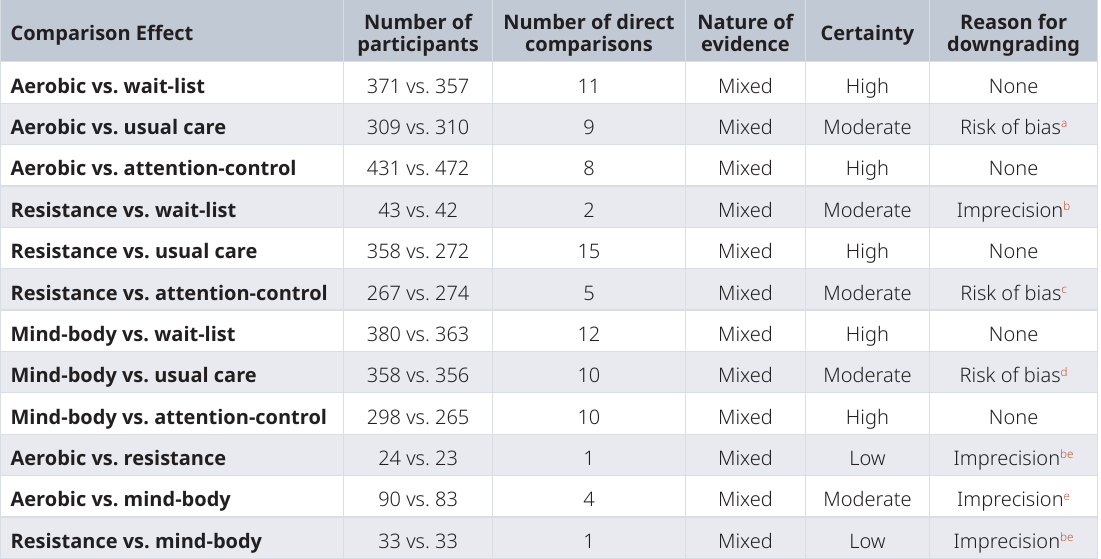
Table 4. Summary of GRADE assessment for the certainty in depressive symptoms